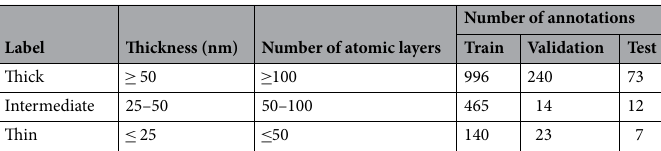
Table 1. Dataset Labels and